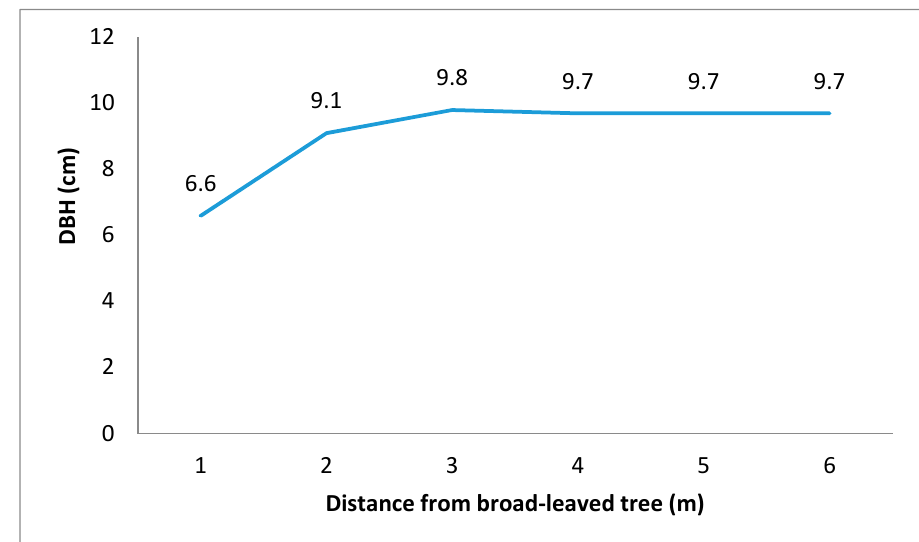
Figure 4. Average diameter at breast height (DBH) at different distances.